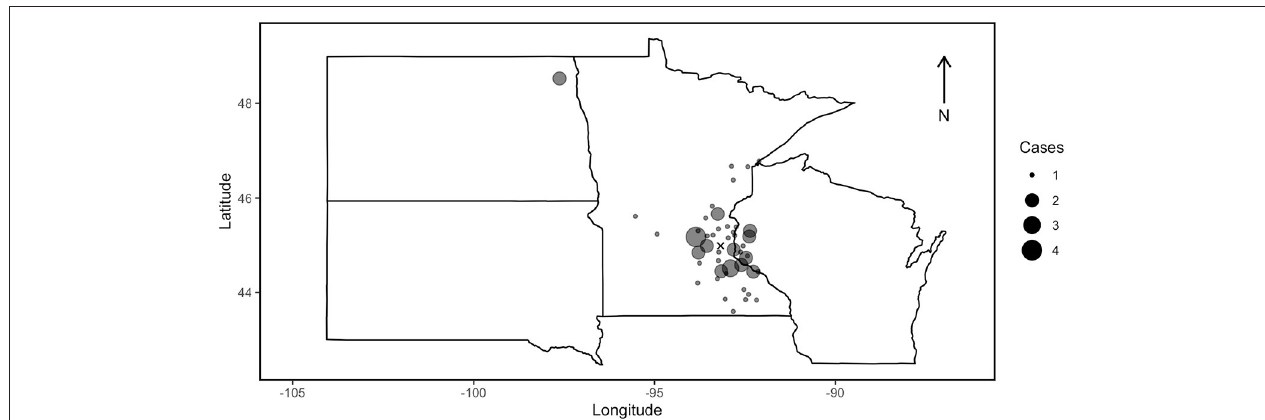
FIGURE 1 | Study area. Locations of P. tenuis diagnosed necropsies performed by the University of Minnesota Veterinary Diagnostic Laboratory (MNVDL) on alpacas, goats, llamas and sheep between 2001 and 2019. Cases describe the number of positive cases identified at mortality at the zip code level in this timeframe. The X marks the location of the MNVDL. The same owner submitted 2 positive cases in the same year in 5 instances; otherwise individual cases were considered independent occurrences of P. tenuis -induced mortality.